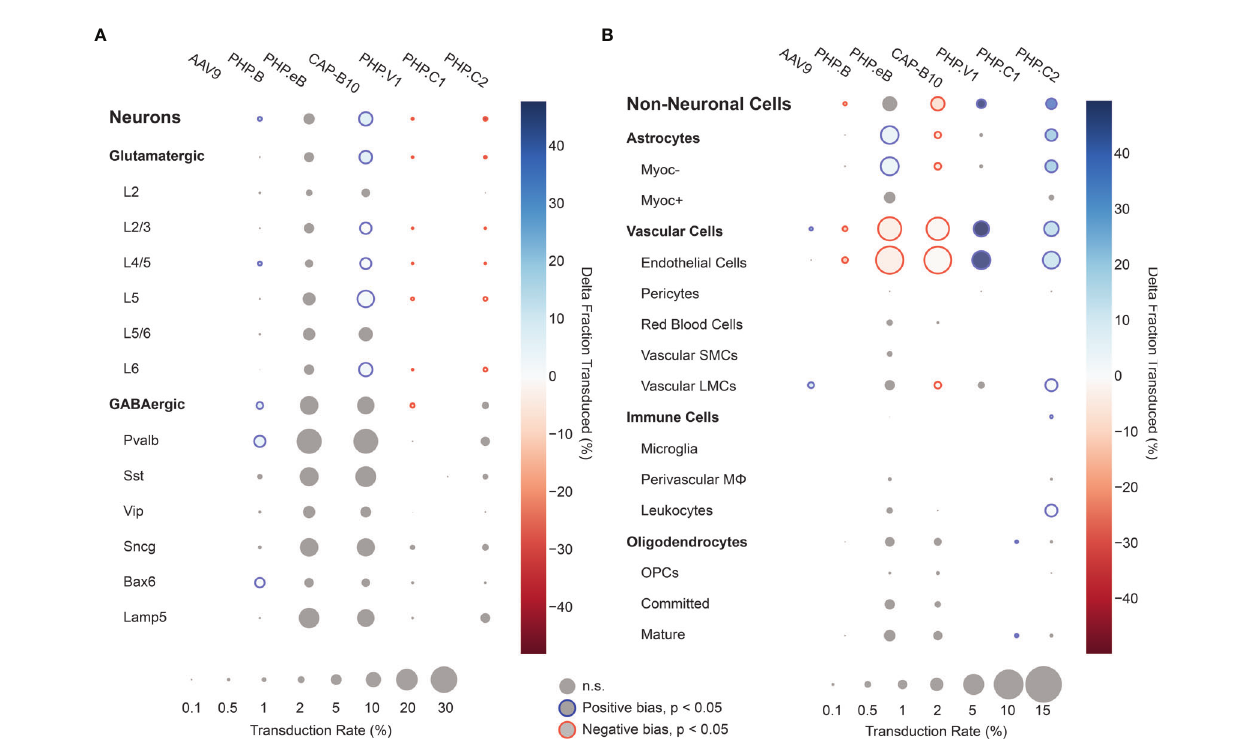
FIGURE 6 | Single animal injections of multiple barcoded rAAVs enables deep, parallel characterization. (A, B) Relative cell type tropism of 7 co-injected rAAVs for neuronal (A) and non-neuronal (B) cell types. The color scale indicates the difference in transduction bias of a variant relative to all other variants in the pool. The area of each circle scales linearly with the fraction of cells of that type with viral transcripts above background. For each variant and cell type, a 2-proportion z score was calculated to compare the number of cells of that type transduced by that variant relative to all other variants combined. Z scores were combined across two single- cell sequencing aliquots using Stouffer ’ s method and corrected for multiple comparisons. Cell types with fewer than 10 transduced cells in either the variant or variants compared against were discarded. Only cell-type biases at an adjusted P-value < 0.05 are colored; otherwise they are grayed